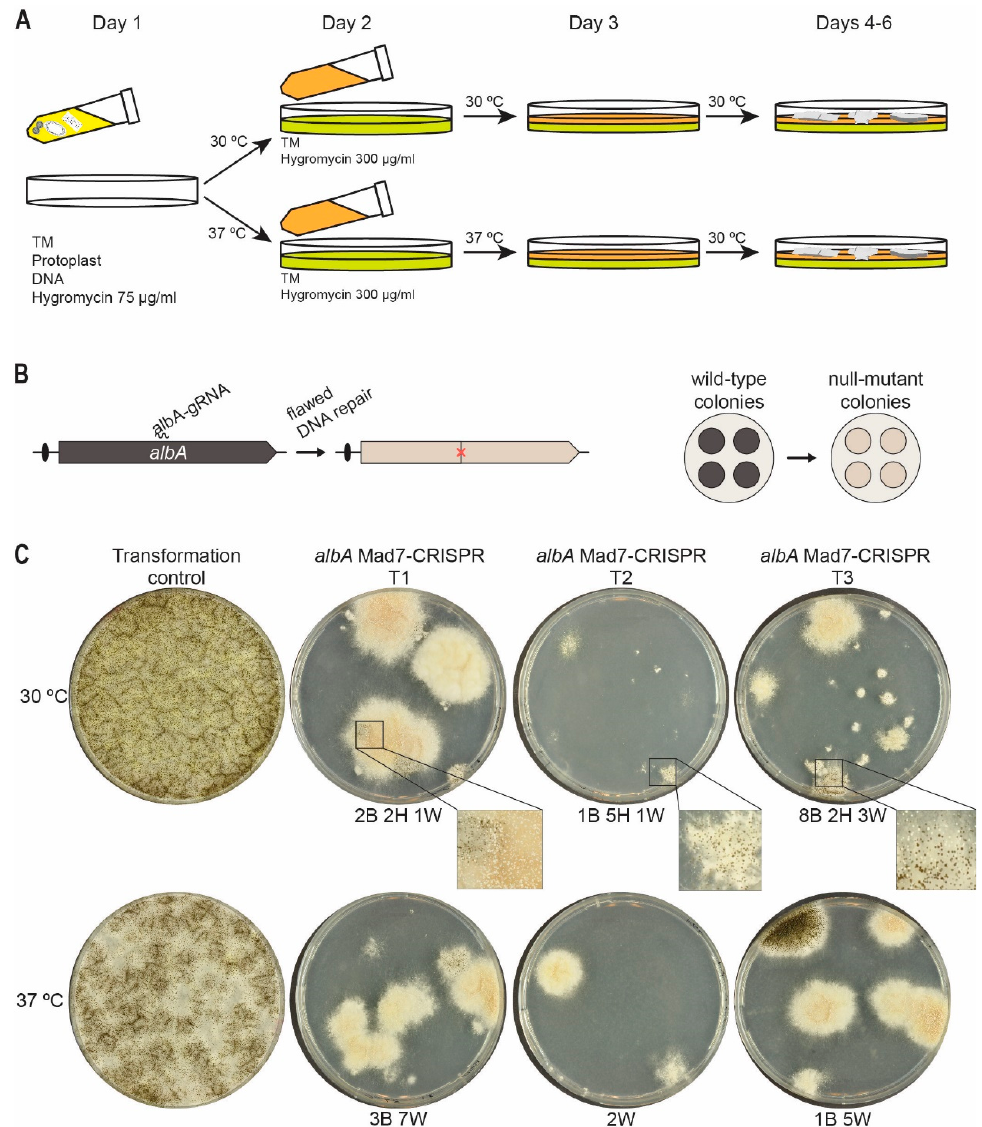
Figure 3. Efficient Mad7 ‐ induced mutagenesis in A. niger . (A) Scheme illustrating the two ‐ phase transformant recovery scheme. Protoplasts transformed with a Mad7 ‐ CRISPR plasmid are mixed with melted medium containing low stringency hygromycin concentration and plated as the first layer; see Materials and Methods for details. When media solidifies, plates are incubated at 30°C favoring growth of A. niger, or 37°C favoring Mad7 activity. After one day of incubation, overlay medium containing high ‐ stringency hygromycin concentration is added to form the second layer, and plates are then transferred for further incubation at the temperature indicated. ( B ) Mad7 ‐ induced mutagenesis of A. niger albA at a specific position indicated by a red X (left) and phenotypic consequence of mutation of colonies, which changes conidia color from wild ‐ type black to mutant albA white (right). ( C ) Experiment showing Mad7 ‐ induced mutagenesis of albA . Transformation of protoplasts using the empty Mad7 ‐ CRISPR plasmid (indicated as control) or with the albA Mad7 ‐ CRISPR vector in three independent trials (indicated as T1 ‐ T3). All experiments were plated at two different temperatures as indicated. For trials T1 ‐ T3, numbers of transformants with specific phenotypes are indicated below plates: B, Black; H, Heterokaryon (black and white); W,